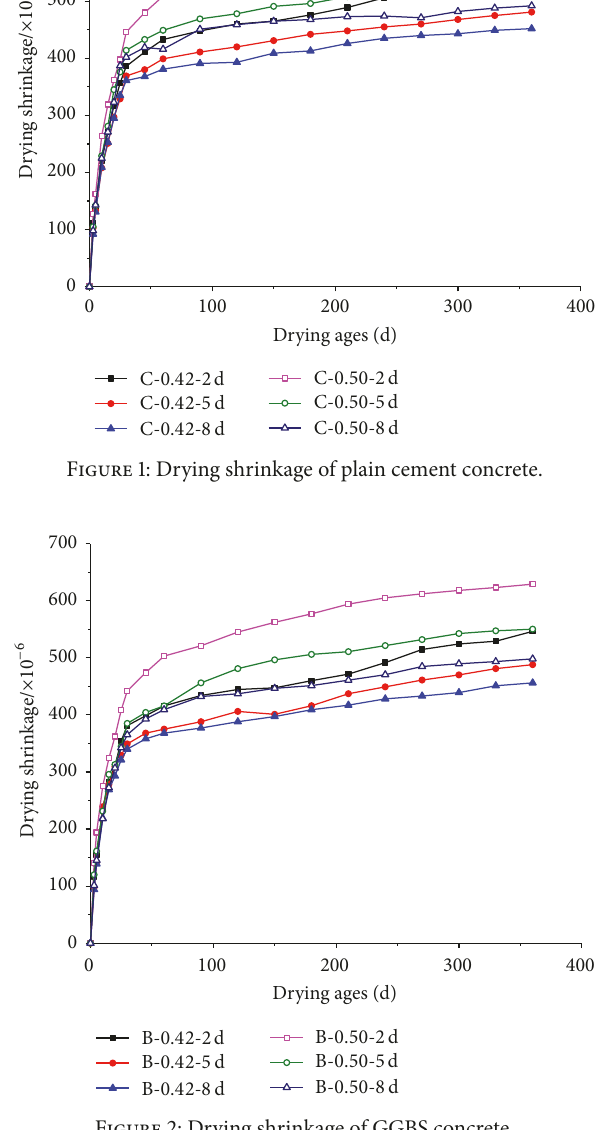
Figure 2: Drying shrinkage of GGBS